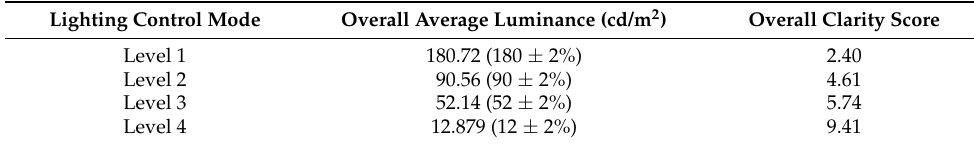
Table 2. Example of the overall average clarity score comparing to the overall average lumi- nance value.